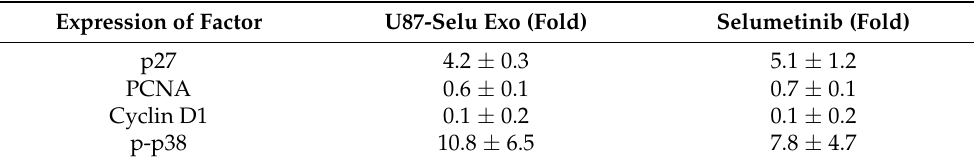
Table 1. The expression of p27, PCNA, cyclin D1, and p-p38 when cells were treated with U87-Selu exo and Selumetinib for 24 h.